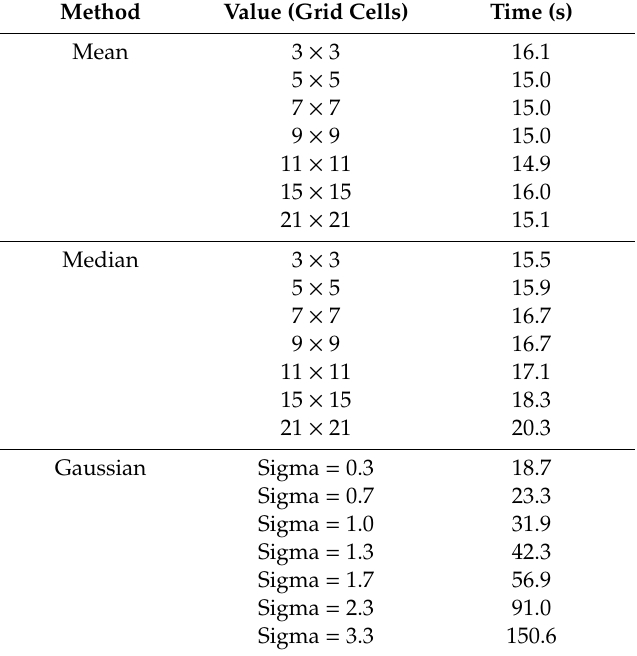
Table 2. The impact of varying filter kernel size on processing performance of various low-pass filtering methods. The Gaussian filter kernel size is a function of the sigma-parameter value. Processing times include file input /